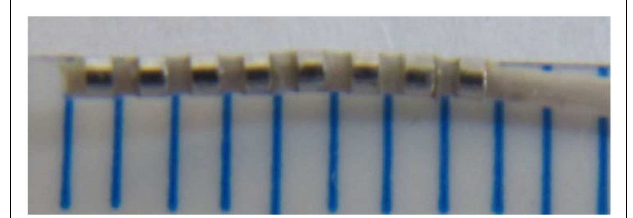
FIGURE 3 |A photograph of an octapolar electrode catheter (CIB’ER Mouse ® , NuMED, Inc., Hopkinton, NY, USA) used for recording from the atrium, His bundle region and ventricle of the anesthetized mouse. The small marks on the ruler are 1mm spacing.